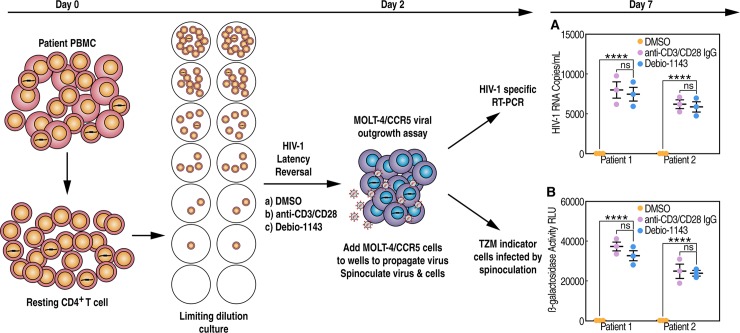
Debio 1143 reverses HIV-1 latency in resting CD4+ T cells from ART-treated patients.Purified resting CD4+ T cells from two ART-treated patients were serially diluted fivefold from 1,000,000 cells per well to 1,600 cells per well and seeded into individual wells of 48-well plates (5 replicates at each dilution). Each dilution was then treated with DMSO, anti-CD3/CD28 IgG-coated microbeads or 1 μM of Debio 1143. At day 2, highly permissive MOLT-4-CCR5 cells were added to each dilution to propagate released virions after latency reversal by LRAs. The ratio of target cells added was 107 MOLT-4-CCR5 cells to the 1x106 resting CD4+ T cell dilution, and 106 MOLT-4-CCR5 cells to all other resting CD4+ T cell dilutions. To increase infection, MOLT-4-CCR5 cells and released virions were spinoculated. Supernatants were collected at day 7 and split for HIV-1 RNA quantification (A) and HIV-1 infection (B) in triplicate. HIV-1 RNA was measured by RT-qPCR. Control experiments showed that >95% of HIV-1 RNA in supernatants could be pelleted by centrifugation at 24,000 g for 1 h and were resistant to DNase I treatment. Infectivity of released virions was scored using TZM indicator cells after spinoculation. TZM infection was scored after 48 h by β-galactosidase activity in cell lysates. P-values are presented. ANOVA and Bonferroni’s multiple comparison tests were used to compare means of different groups. Bar graphs indicate each sample point, mean, and SEM. Key for adjusted p-values from Bonferroni’s multiple comparison tests on graphs: ns = no significance, * = 0.01≤p<0.05, ** = 0.001 ≤p<0.01, *** = 0.0001≤p<0.001, and **** = p<0.0001.